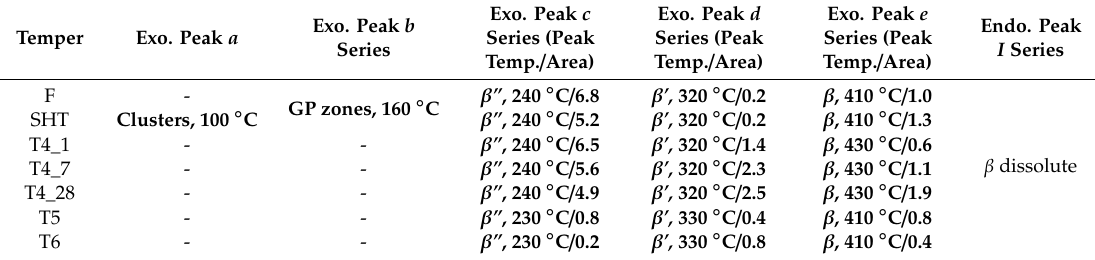
Figure 10. DSC heating curves of Al-Mg-Si AA6082 alloy subjected to ( a ) F and SHT, ( b ) T4, and ( c ) T5 and T6 treatments. Table 5. Summary of DSC characterizations of the Al-Mg-Si AA6082 alloy.